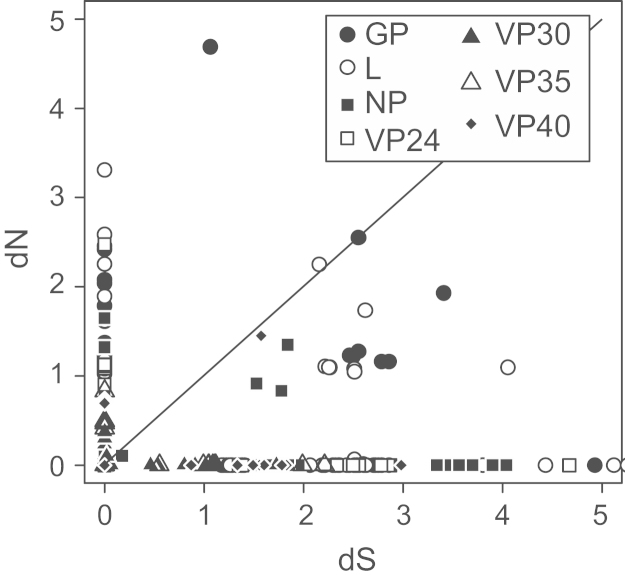
Number of synonymous (dS) and non-synonymous (dN) changes per site. Changes as calculated by the single-likelihood ancestor counting (SLAC) model (Kosakovsky Pond and Frost, 2005). The line indicates dN=dS.